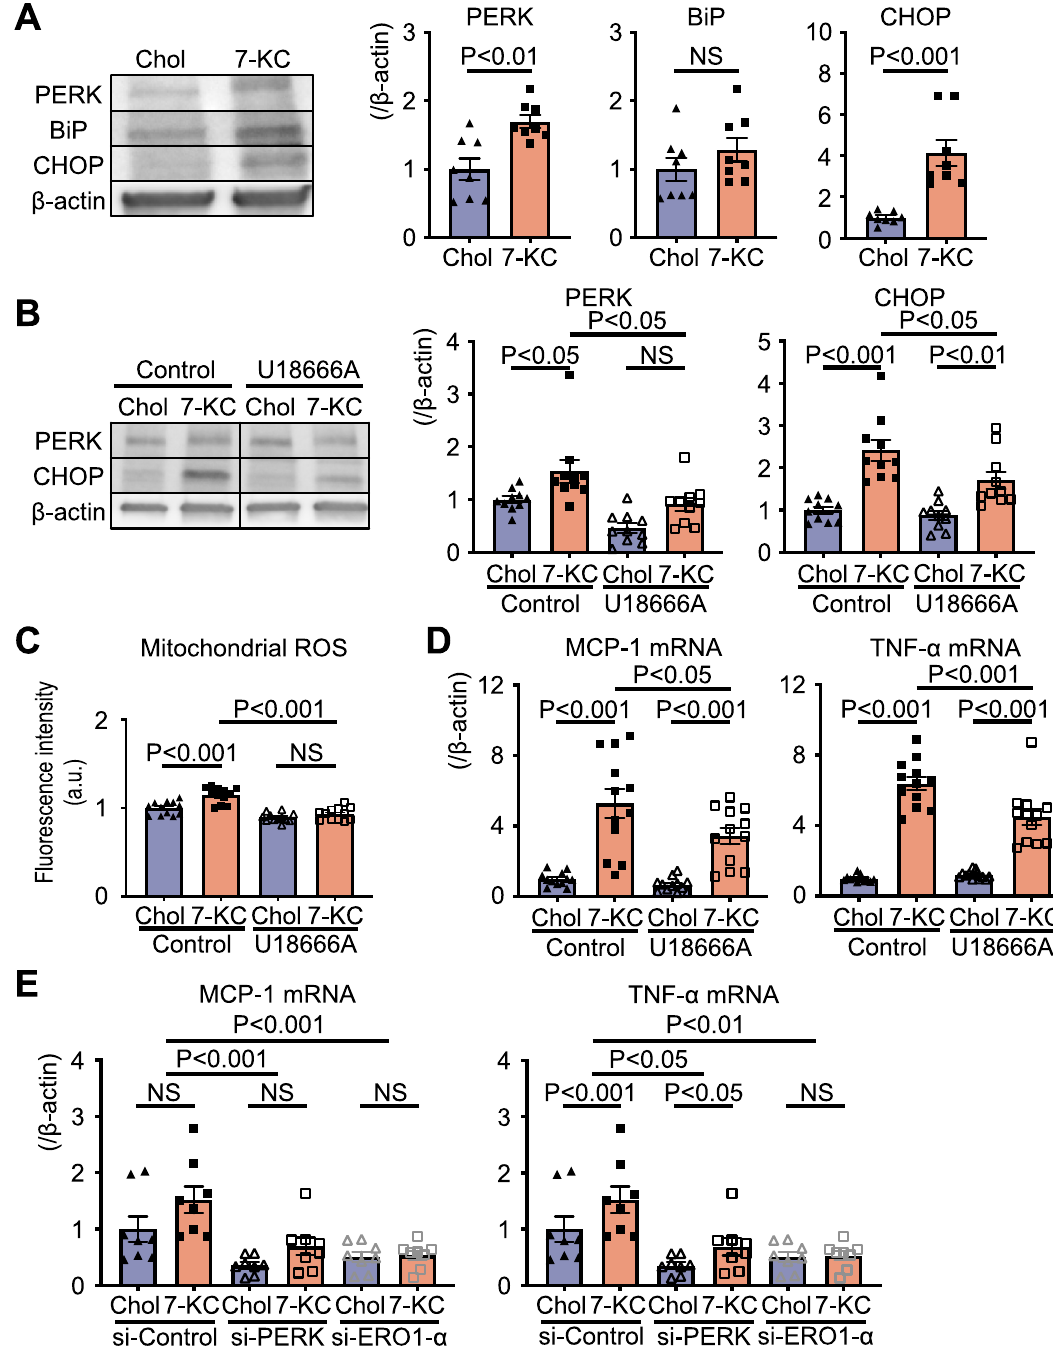
Figure 5. 7-KC induced ER stress and subsequently ROS. ( A ) Proteins related to ER stress in peritoneal macrophages treated with 10 µM cholesterol or 7-KC for 24 h. N = 8. The data were analyzed by unpaired t test. Original blots/gels are presented in Supplementary Fig. S7. ( B – D ) Effect of the cholesterol transport inhibitor U18666A on peritoneal macrophages pretreated with 3 µM U18666A for 1 h. ( B ) Proteins related to ER stress. N = 10. The data were analyzed by one-way ANOVA, followed by Tukey’s post-hoc multiple comparison test. Original blots/gels are presented in Supplementary Fig. S8. ( C ) Mitochondrial ROS measured using MitoSOX. N = 12. The data were analyzed by one-way ANOVA, followed by Tukey’s post-hoc multiple comparison test. ( D ) Expression of cytokines quantified by RT–PCR. N = 12. The data were analyzed by one-way ANOVA, followed by Tukey’s post-hoc multiple comparison test. ( E ) Effect of siRNA specific for PERK or ERO1-α. Expression of cytokines quantified by RT–PCR. N = 8. The data were analyzed by two-way ANOVA, followed by Tukey’s post-hoc multiple comparison test. Chol, cholesterol; 7-KC, 7-ketocholesterol; PERK, PKR-like endoplasmic reticulum kinase; BiP, binding immunoglobulin protein; CHOP, C/EBP homologous protein; ROS, reactive oxygen species; ER, endoplasmic reticulum; ERO1-α, ER oxidase 1 α; si-Control, nontargeted control siRNA; si-PERK, siRNA against PERK; si-ERO1-α, siRNA against